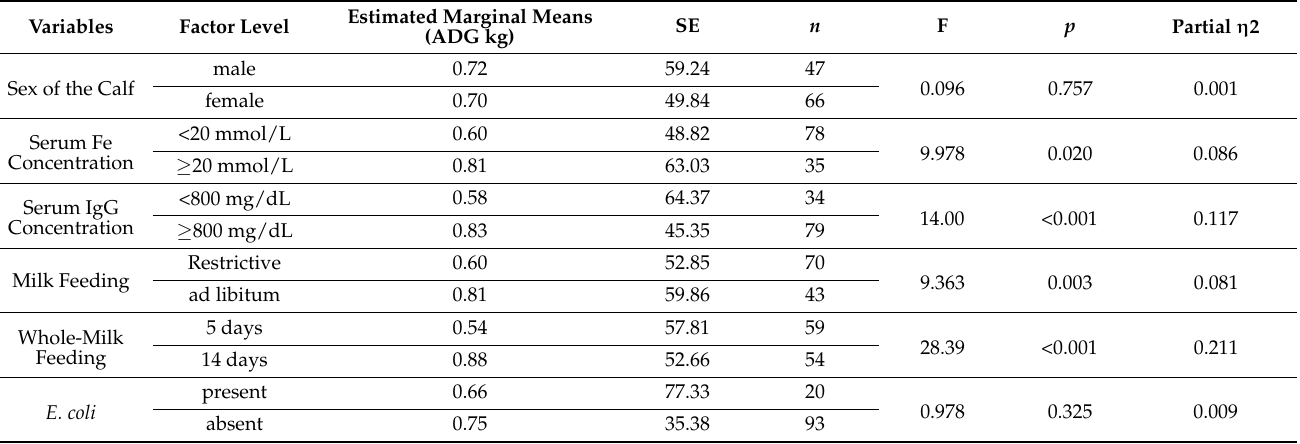
Table 2. Variables associated with calf average daily weight gain (ADG) (kg/day) between 1 and 14 days of age of 113 Holstein calves on eight commercial dairy farms.